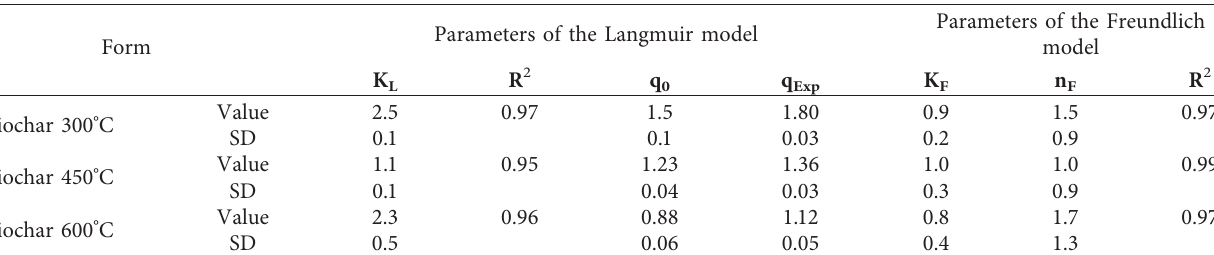
Parameters of the Freundlich